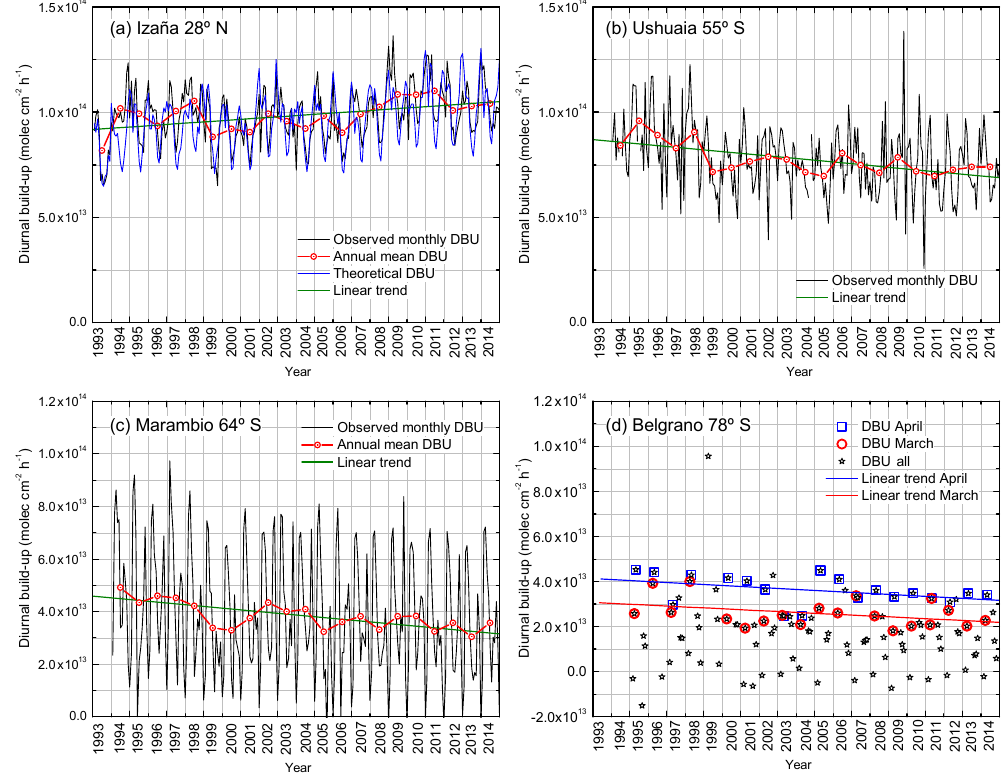
Figure 7. Diurnal NO 2 build-up in moleccm − 2 h − 1 for the four DOAS stations. (a) – (c) : Observed DBU (black lines). Annual means (red lines). Linear trends (dotted lines). The computed DBU is plotted in (a) (blue line). (d) The Belgrano DBU for all available months (black stars). The months of March and April are highlighted with red circles and blue squares, respectively.